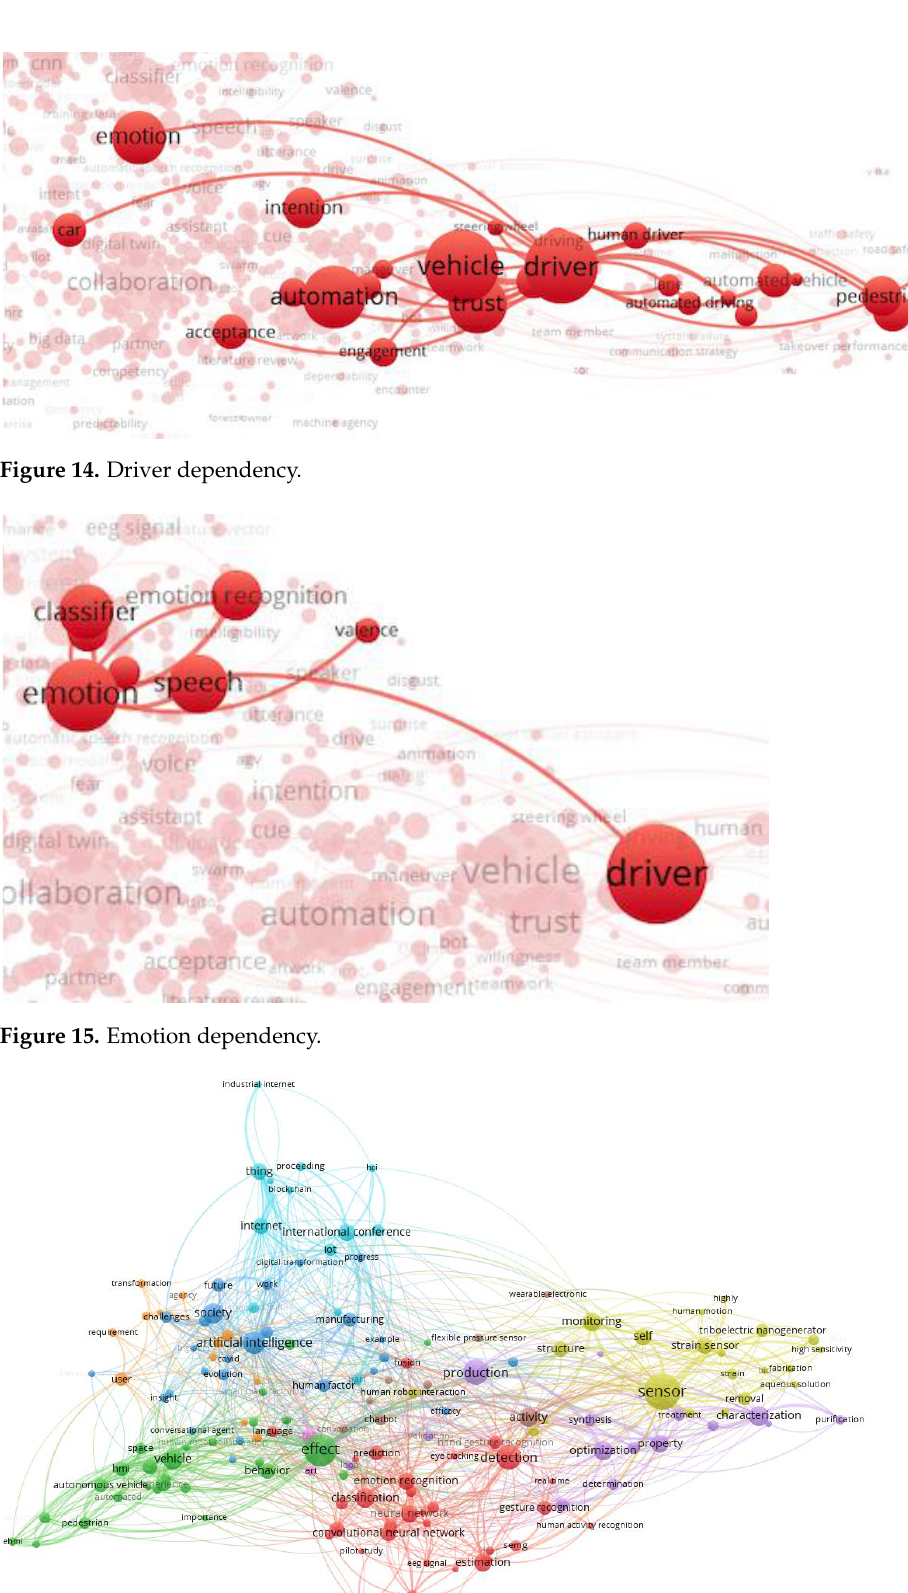
Figure 16. Term co-occurrence map based on provided publications Scopus. One of the key dependencies highlighted within the analysis, linking to different scopes, is sensors (Figure 17). Here, several strong connections to issues such as artificial intelligence, monitoring, sensing, estimation, or neural networks can be identified. How- ever, there is no explicit indication here of the issues present in the 5C model.